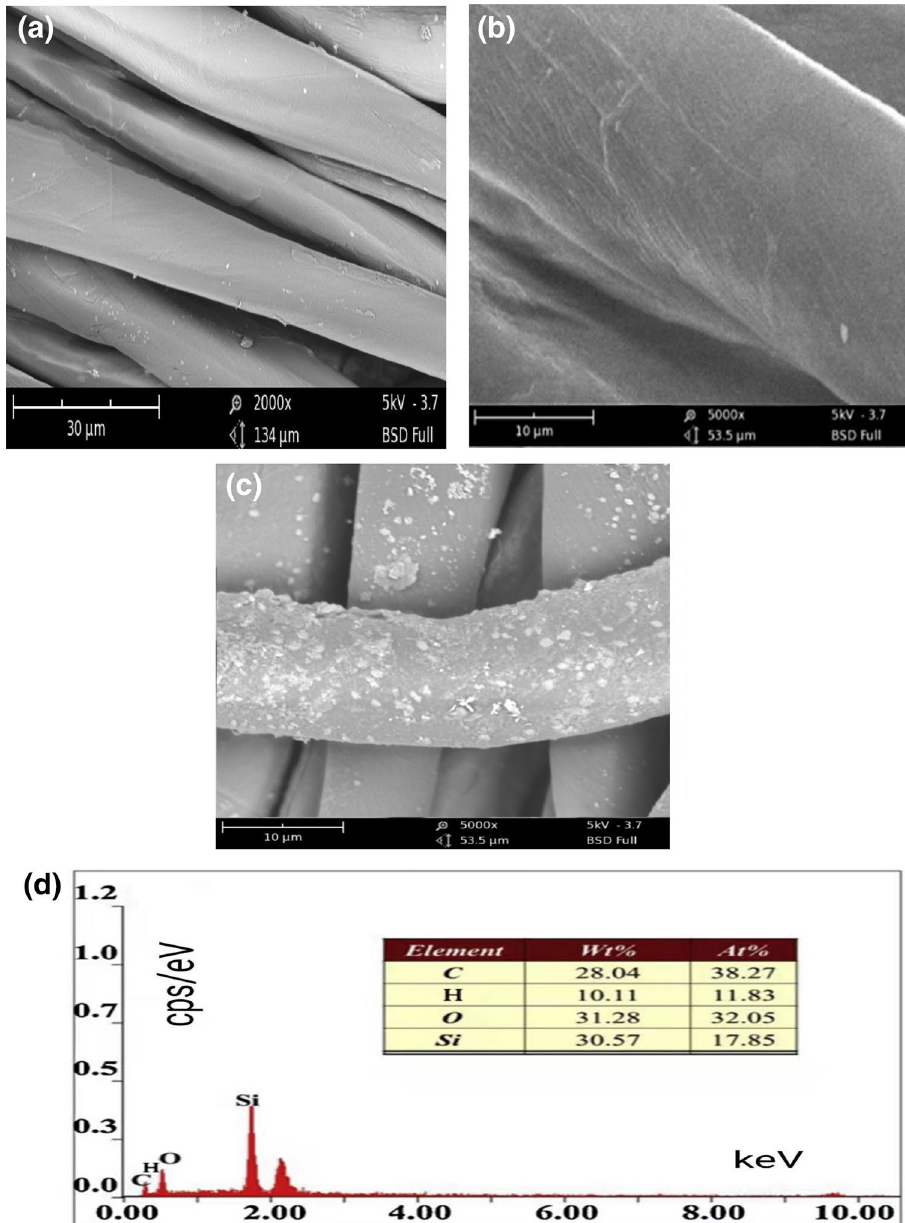
Fig. 4 Different magnifications SEM images of a , b control nonwoven cotton fabric, c HDTMS-treated nonwoven cotton fabric. d EDX spectrum of HDTMS-treated nonwoven cotton